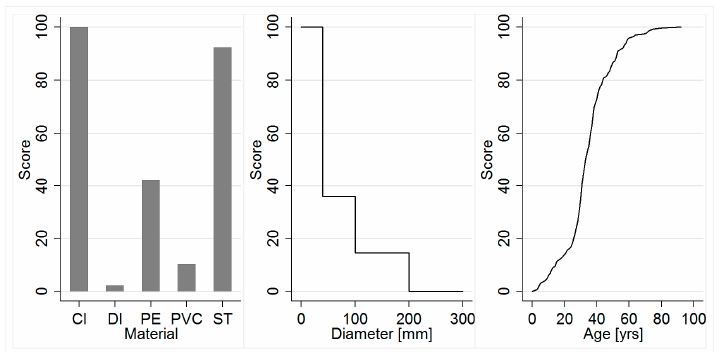
Figure 3. Scores of the condition driven criteria for the water distribution network.